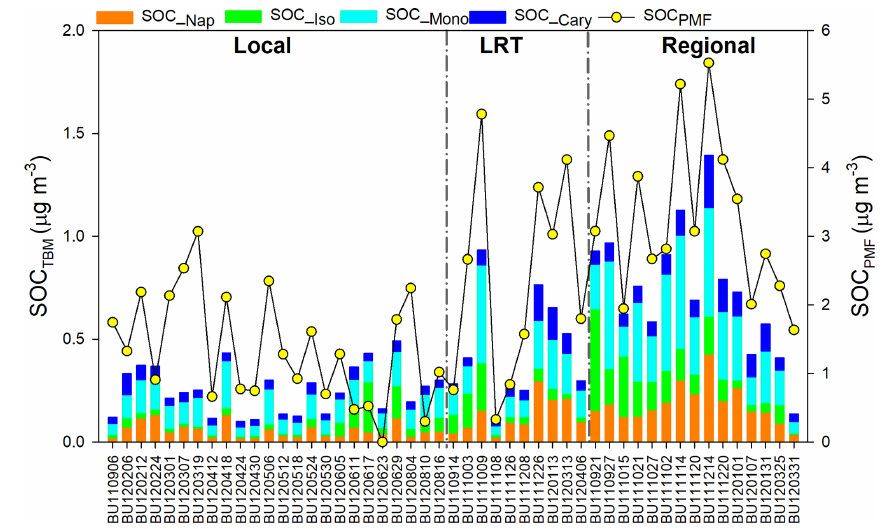
Figure 4. Temporal variations of SOC PMF and SOC TBM